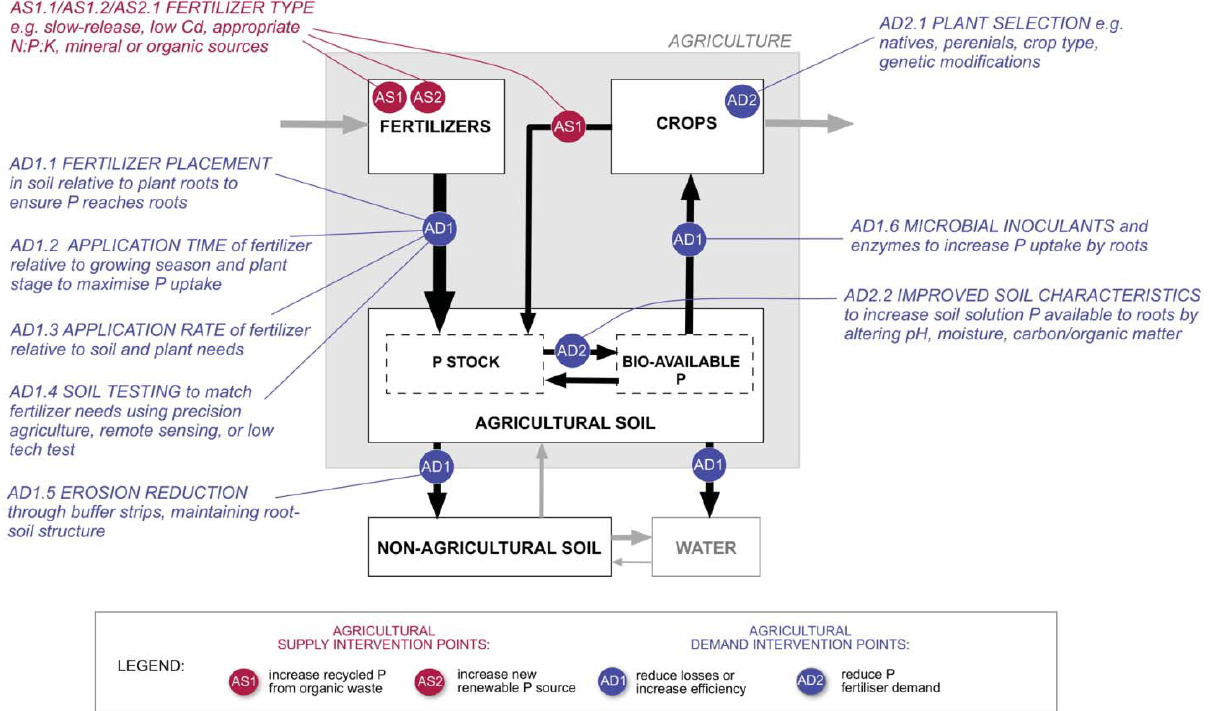
Figure 4. Sustainable phosphorus measures in agriculture—interventions in fertilizer selection and use, crop selection and soil